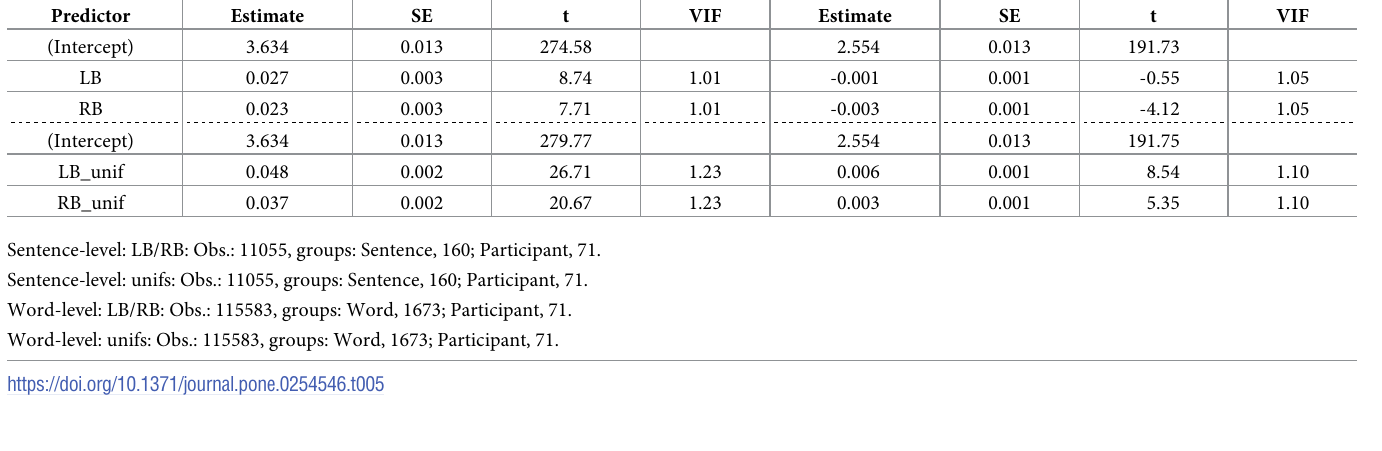
Table 5. Results of the mixed-effects model with only SC predictors. Sentence-level Word-level Predictor